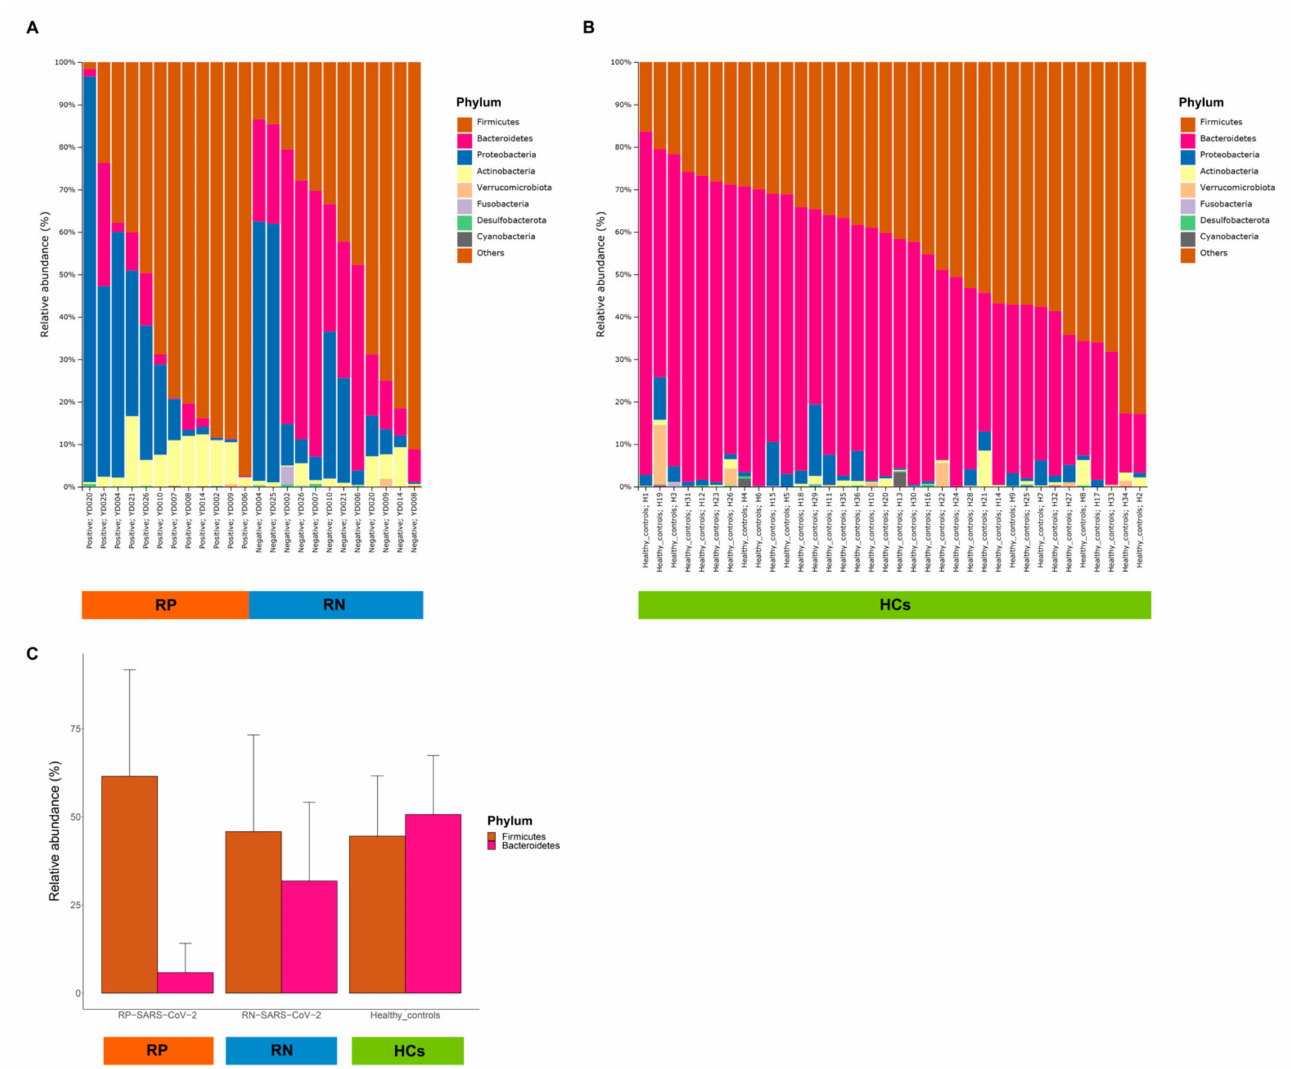
Figure 5. Comparison of taxonomic compositions of gut microbiota at the level of phylum. ( A ) Relative abundance of phyla between two time points (respiratory positive (RP)-SARS-CoV-2 and respiratory negative (RN)-SARS-CoV-2) in 12 patients with COVID-19. ( B ) Relative abundance of phyla in 36 individuals as healthy controls (HCs). ( C ) The mean relative abundance of Firmicutes and Bacteroidetes among patients with COVID-19 and